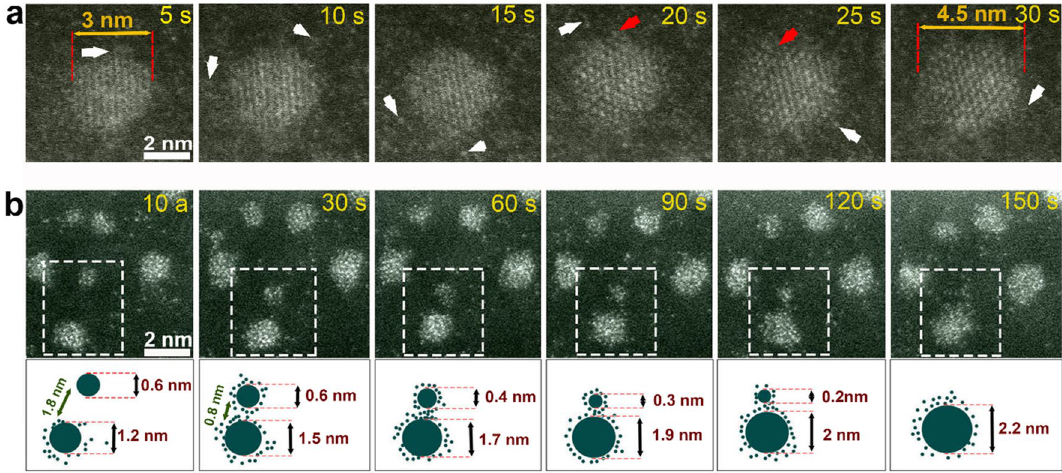
Figure 5. Nanocrystal growth by monomer attachment and Ostwald ripening. ( a ) ADF-STEM time-series showing a particle growing by monomer attachment, where visible, attachment of free Pt atoms (white arrows) form new atomic layers on top of the old ones (red arrows). ( b ) ADF-STEM time-series showing a particle growing by Ostwald ripening, where single atoms and clusters migrate through liquid from the smaller particle (top) to the larger particle (bottom). In the bottom, schematic illustration of the Ostwald repining process. The yellow arrows highlight the single atoms and clusters detached from the smaller particle. Images are shown in false